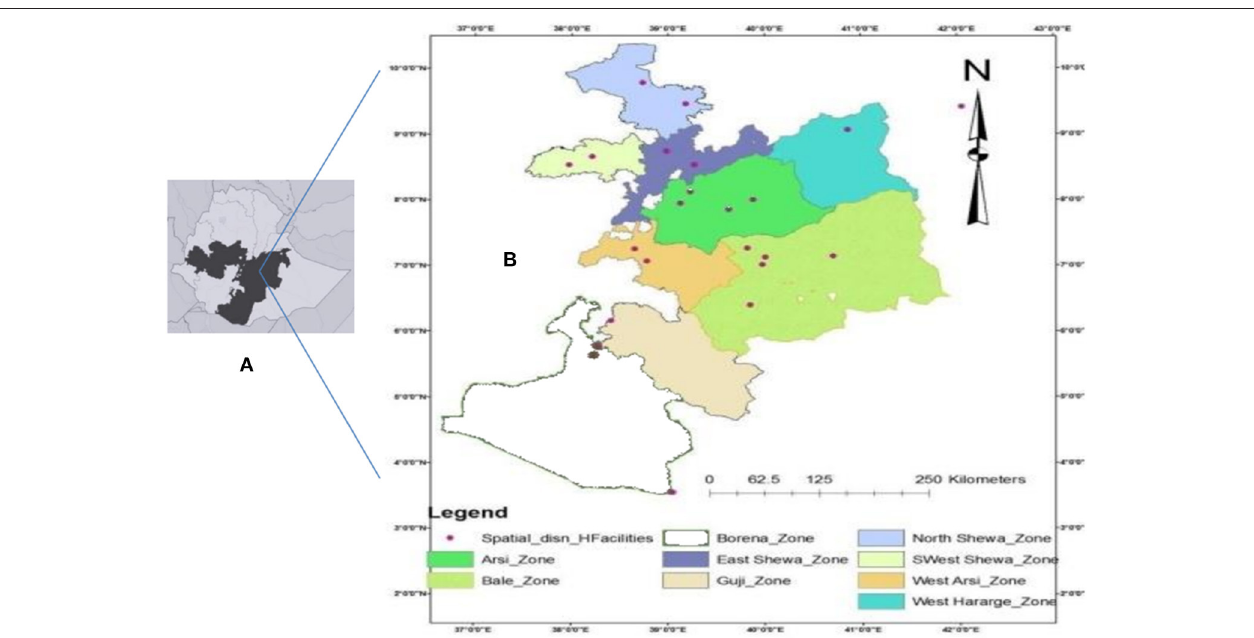
FIGURE 1 | Map of Ethiopia showing Oromia Region, shaded (A) and Oromia Region showing Zones included in the study and spatial distribution of the health care facilities from where participants were sampled (B) .